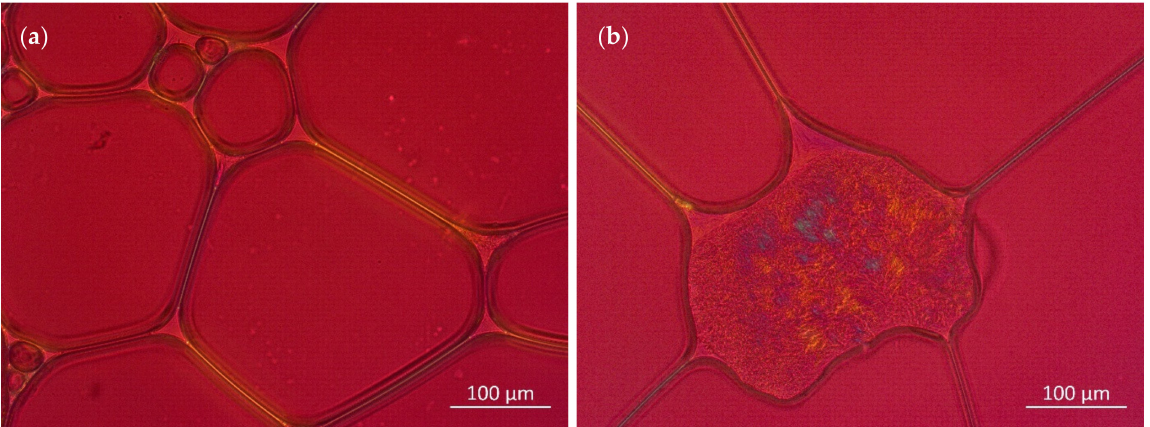
Figure 11. Polarization microscopic images of foams generated from the ( a ) LG + Premix 3 and ( b ) LG + Premix 5.